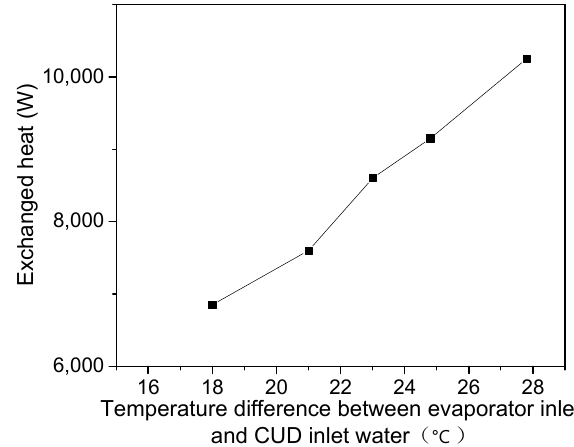
Figure 10. Change of heat exchange with temperature di ff erence between inlet air of evaporator and inlet water of CDU.